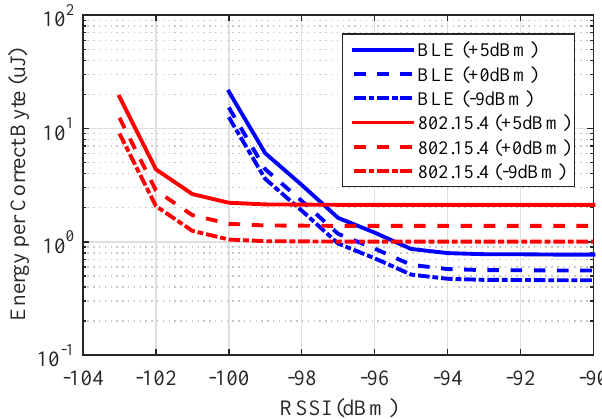
Figure 5. Energy consumption of the transmission of a successful byte (accounting for potential retransmissions) for various transmission power levels, considering L = 21